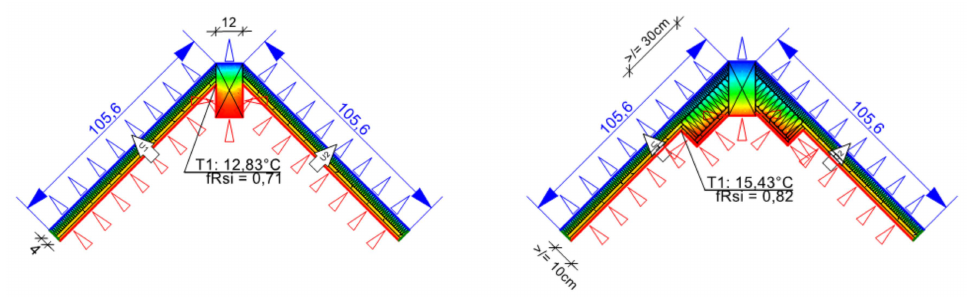
Figure A24. Before and after the thermal bridge retrofit of a roof ridge (created with ThermCad thermal bridge simulation calculator). Table A26. Retrofit components and costs of the thermal bridge retrofit of a roof ridge [38,39]. Pos.